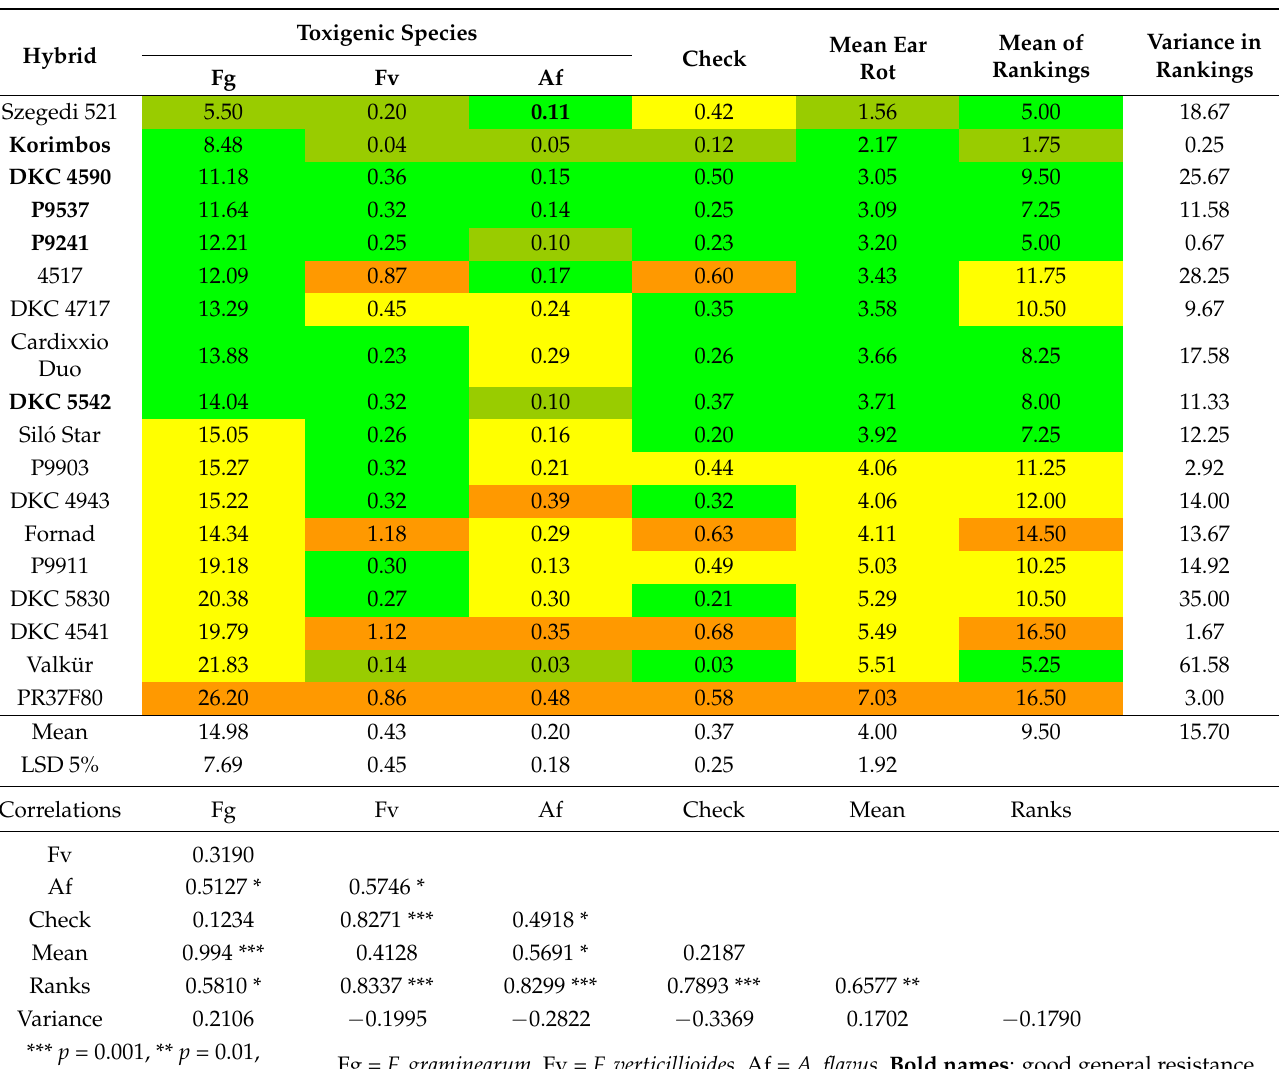
Table 3. Kernel resistance of commercial maize hybrids to toxigenic fungi following artificial inocula- tion and ear rot severity (%)